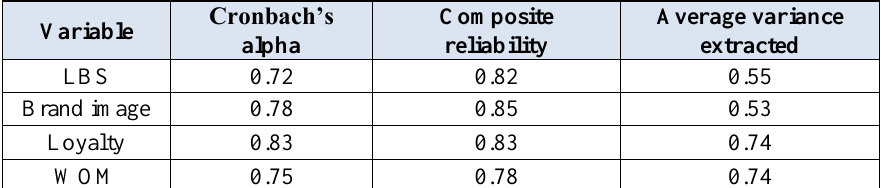
Table 1. Reliability and convergent validity